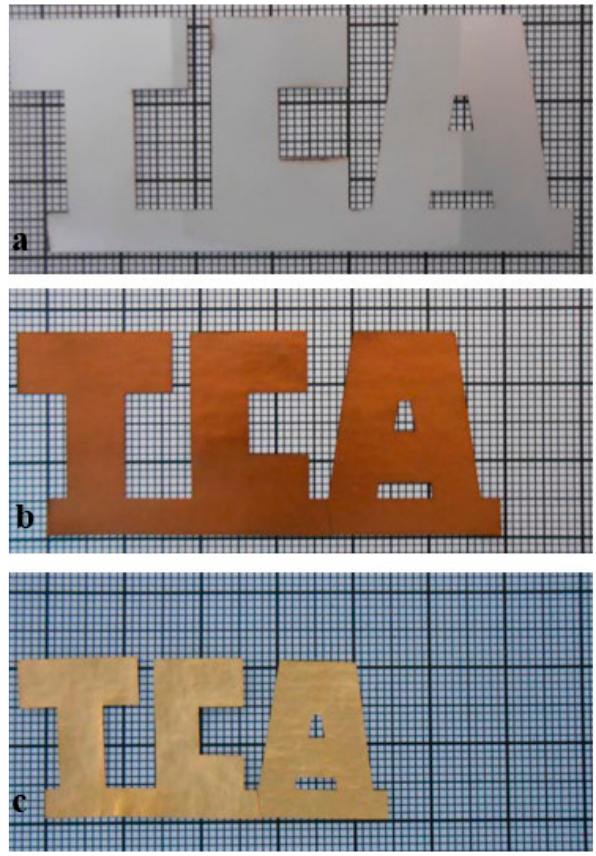
Figure 5. Effect of gold parting (b) and annealing treatments (c) on an Au 25% -Ag alloy specimen (a) with TCA logo